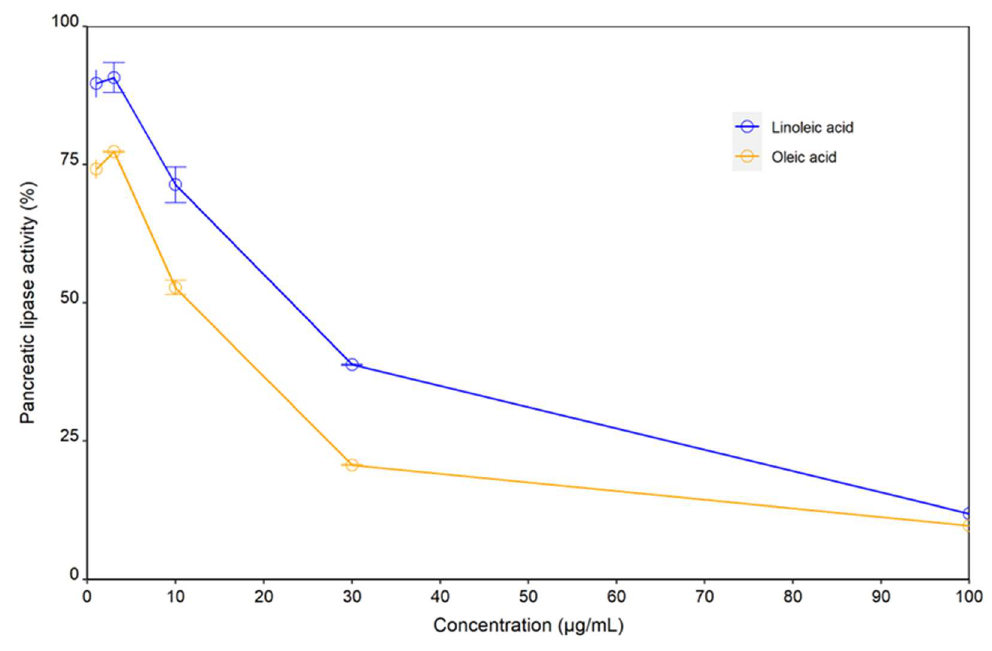
Figure 5. In vitro inhibitory activity of linoleic acid and oleic acid against pancreatic lipase at varying concentrations. Linoleic acid and oleic acid exhibited an IC50 of 23.1 µ g/mL (82.4 µ M) and 11.7 µ g/mL (41.4 µ M), respectively.